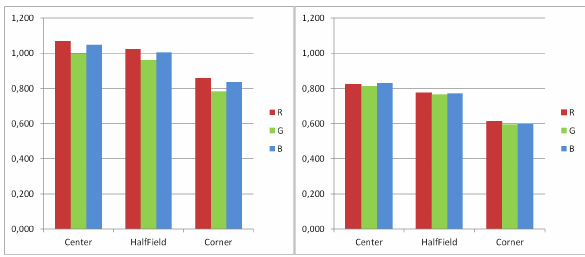
Figure 10. Results for resolving power measurements [line/pixel] under static (left) and kinematic (right)